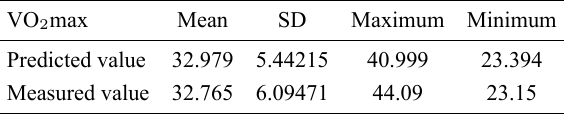
Table 3. Measured and predicted values.